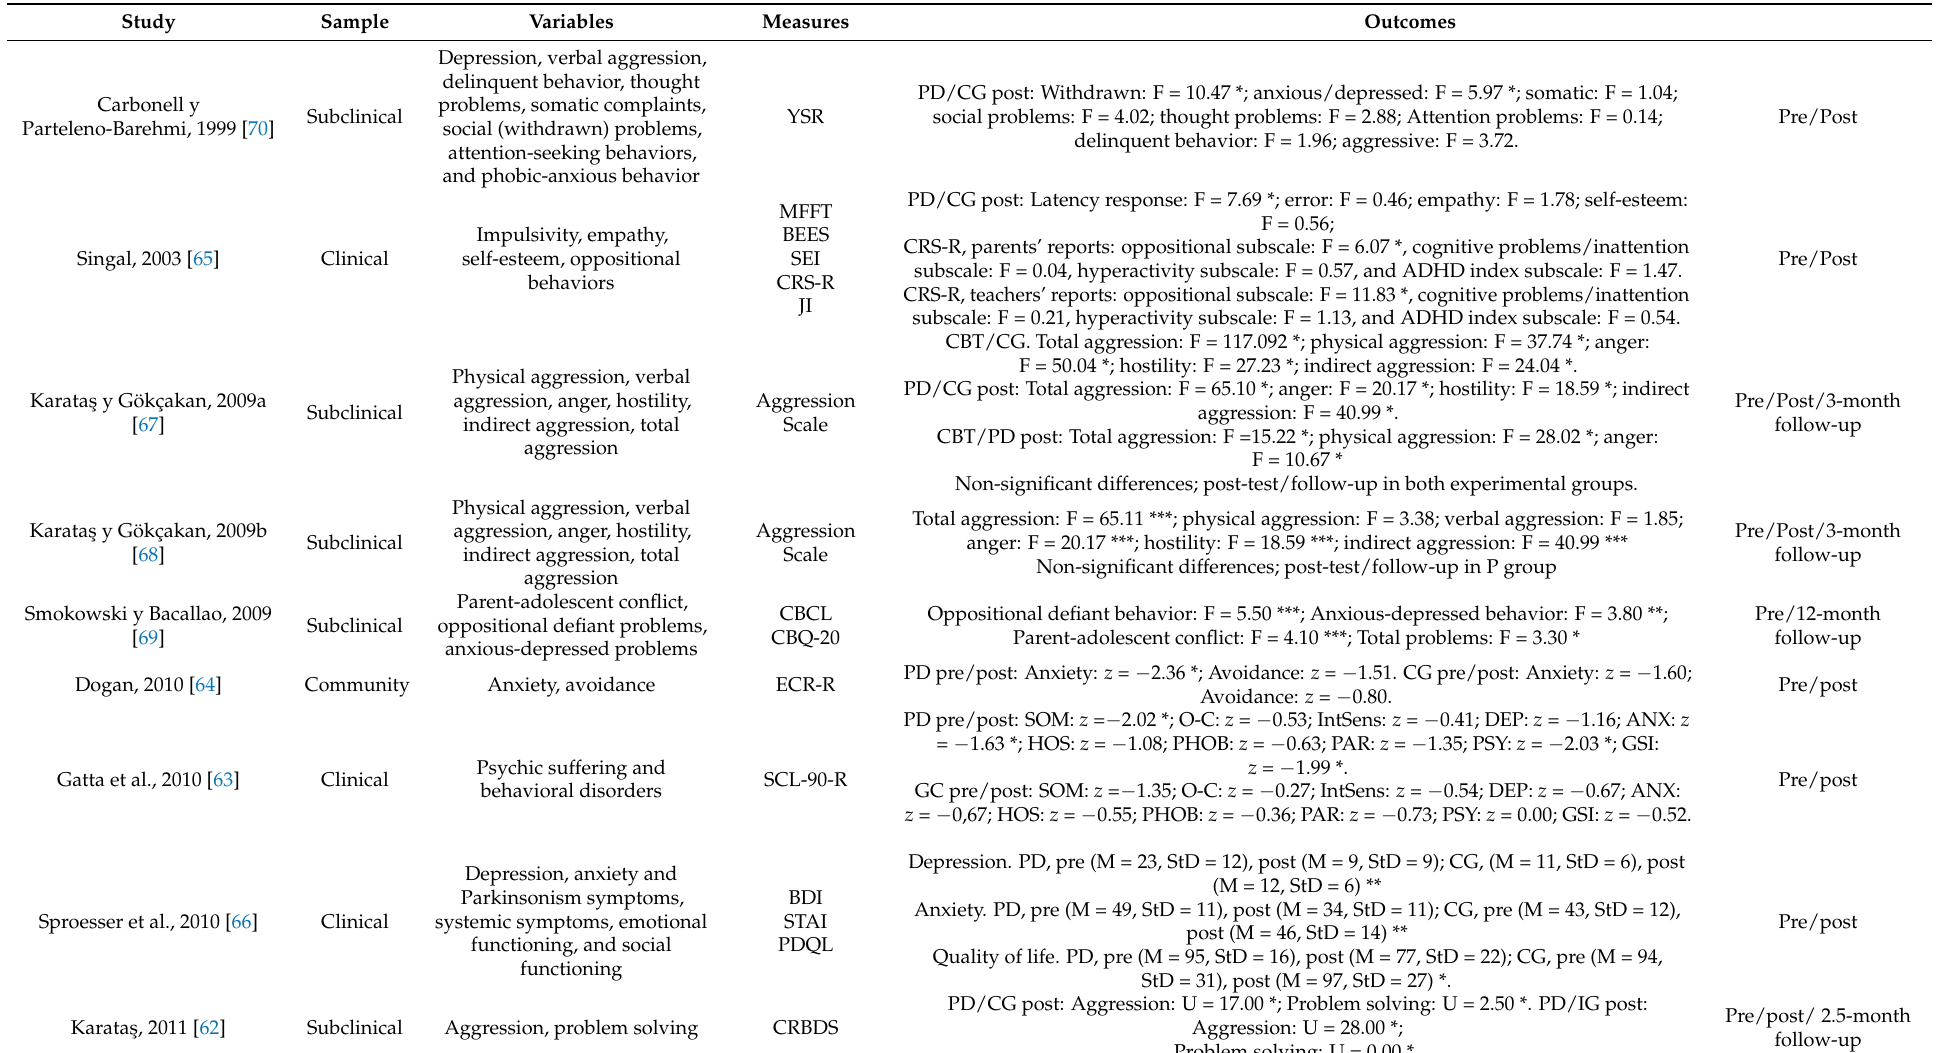
Table 3. Samples, variables, measures, and outcomes of psychodrama interventions applied to different